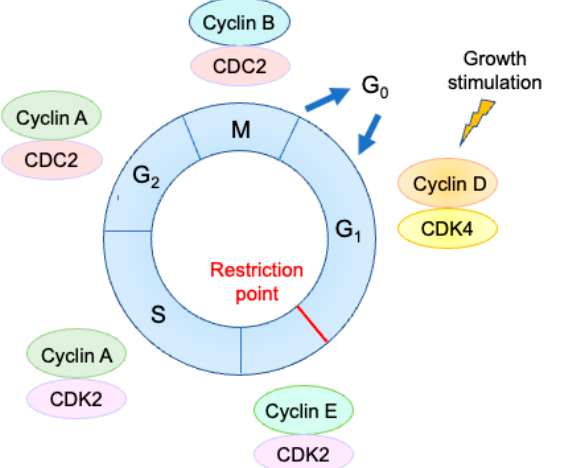
Figure 2. Cell cycle regulation by cyclins and CDKs. Each stage of the cell cycle is governed by specific cyclin/CDK complexes. Progression of the cell cycle to the restriction point, located in late G1, is dependent on growth stimulation. After passing through the restriction point, cell cycle progression proceeds autonomously through the end of mitosis.